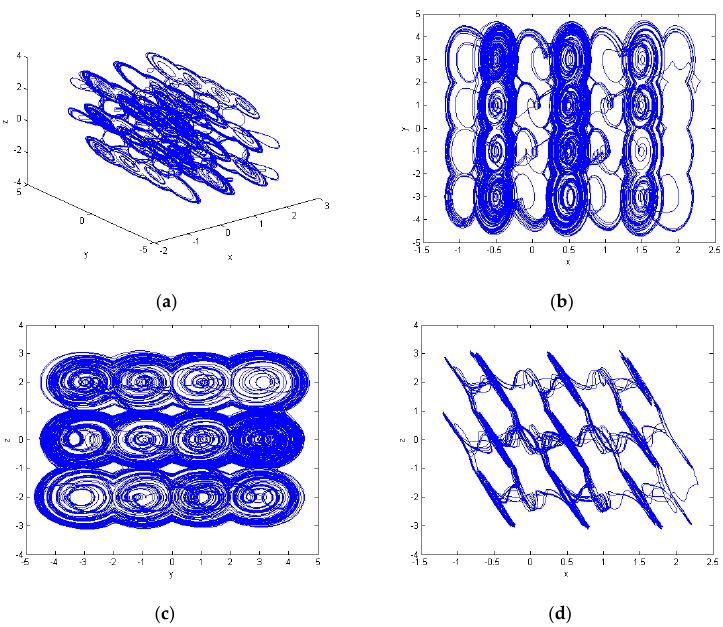
Figure 3. (Color online) chaotic attractor with 3 × 4 × 3-scroll of system (2) with n 1 = 1, n 2 = 2, f 1 ( y ) = f 12 ( y ) , f 2 ( z ) = f 21 ( z ) , N 12 = 1, N 21 = 0, and ( x 0 , y 0 , z 0 ) = ( 0.1,0,0 ) : ( a ) phase diagram in three-dimensional space; ( b ) projection on the x–y plane; ( c ) projection on the y–z plane; and ( d ) projection on the x–z plane. Type 3: n 1 = 2, n 2 = 1, f 1 ( y ) = f 11 ( y ) , f 2 ( z ) = f 22 ( z ) , N 11 = 0, and N 22 = 1, the chaotic attractors with 3 × 3 × 4-scroll are depicted in Figure 4.